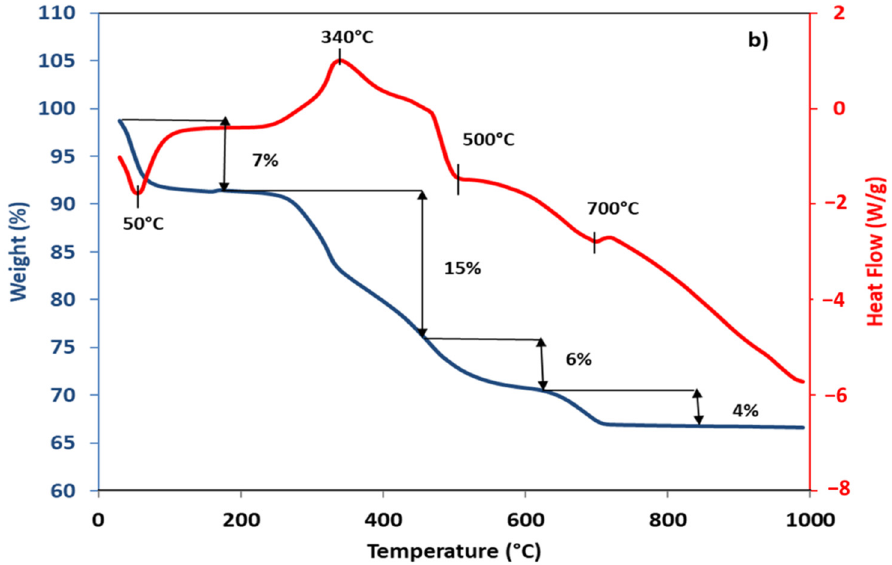
Figure 1. ATG/DSC curves of the formulation used to make all bio-based membranes after sintering.